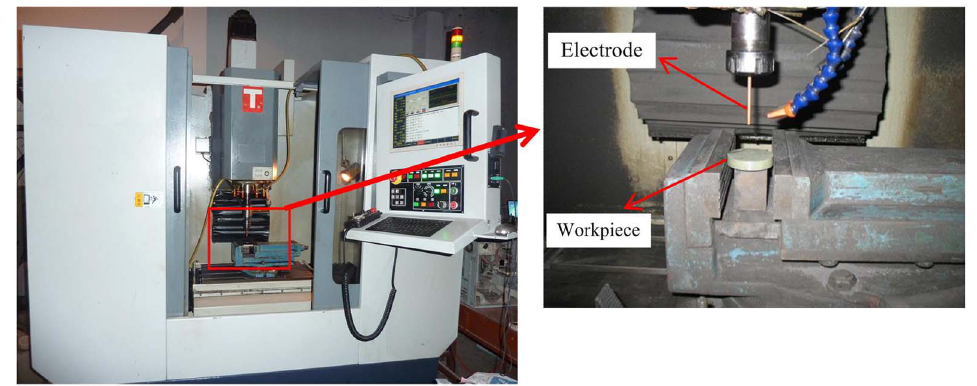
Figure 1. EDM milling machine for machining ZnO/Al 2 O 3 ceramic.